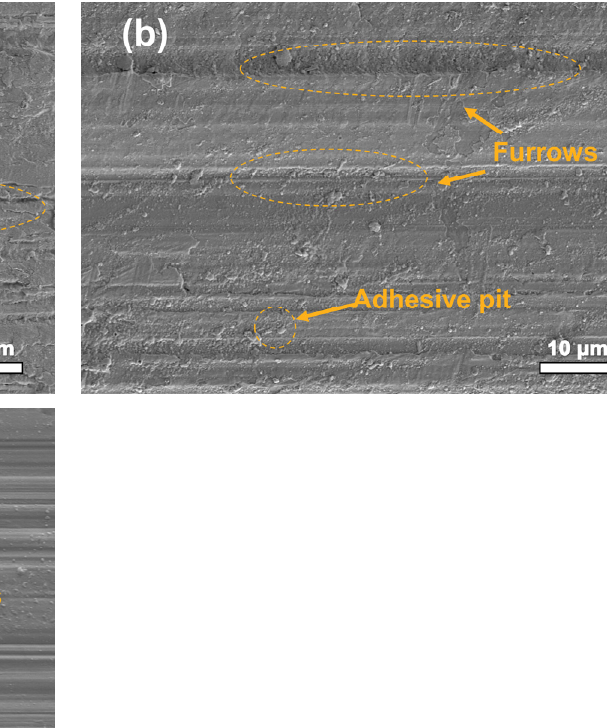
Figure 9. Photographs of agar plates of S. aureus after incubation with PEEK/10 wt% PTFE and PEEK/10 wt% PTFE/0.5 wt% BP. Table 1. A summary of the antibacterial rates of three repeated antibacterial experiments. Serial Number Concentration of the Colon (CFU/mL) Antibacterial Rate (%) Control Group Experimental Group